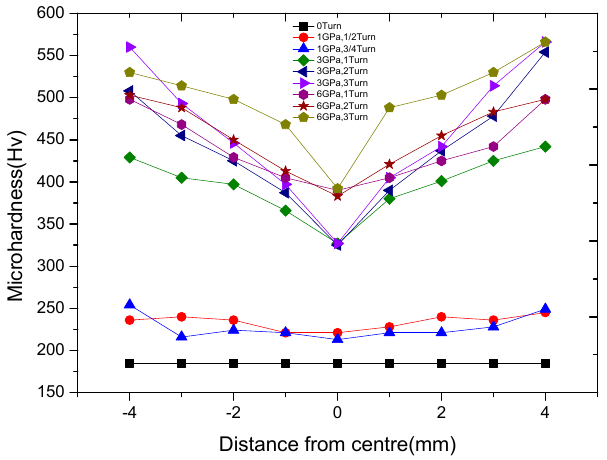
Figure 8. Hardness profiles after processing under 1, 3 and 6 GPa for different numbers of turns.